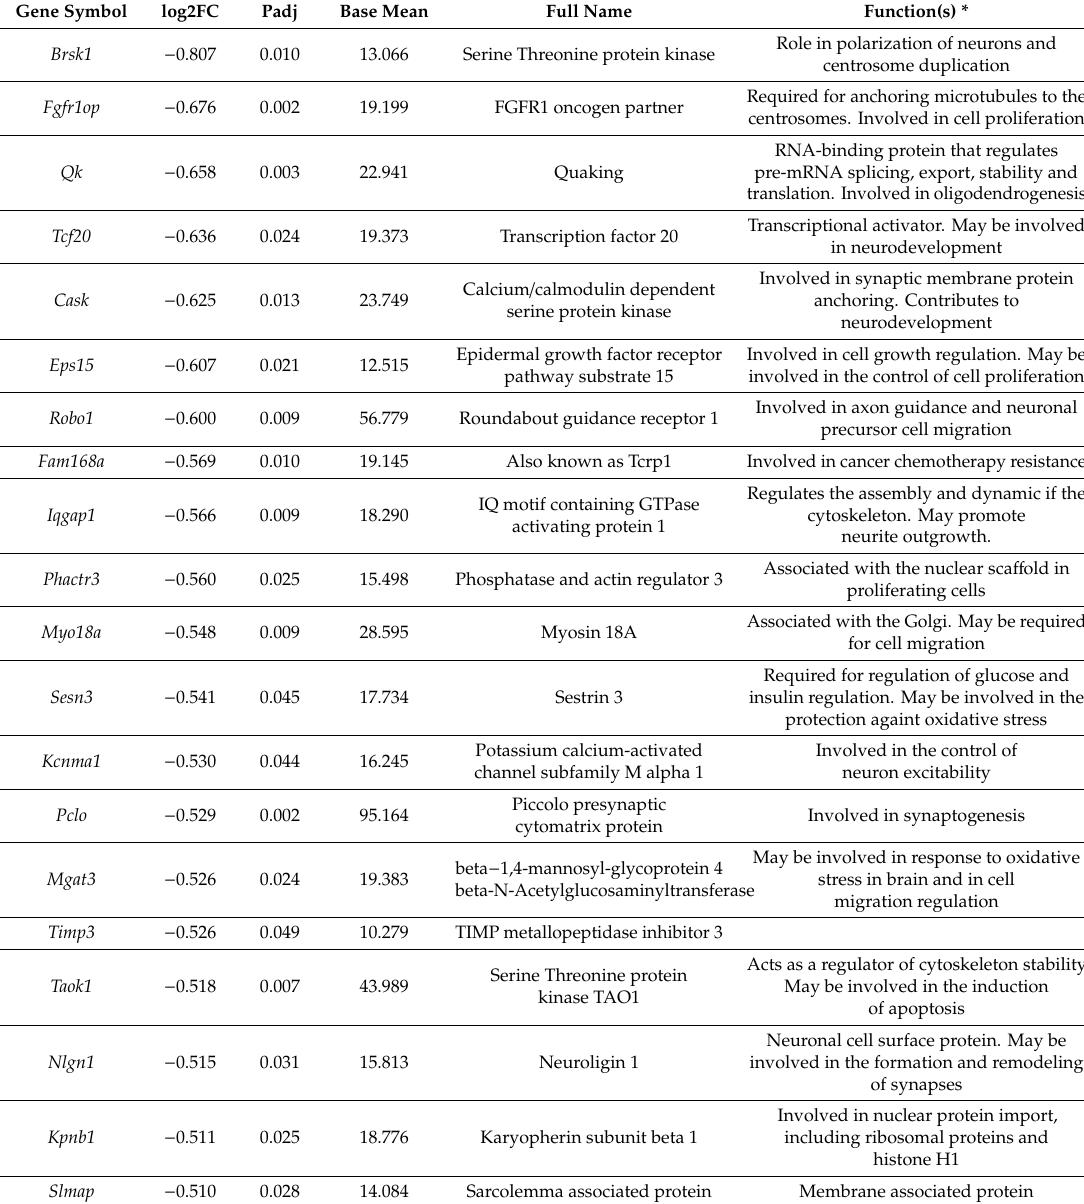
Table A2. Top 20 downregulated genes in the protein-restricted